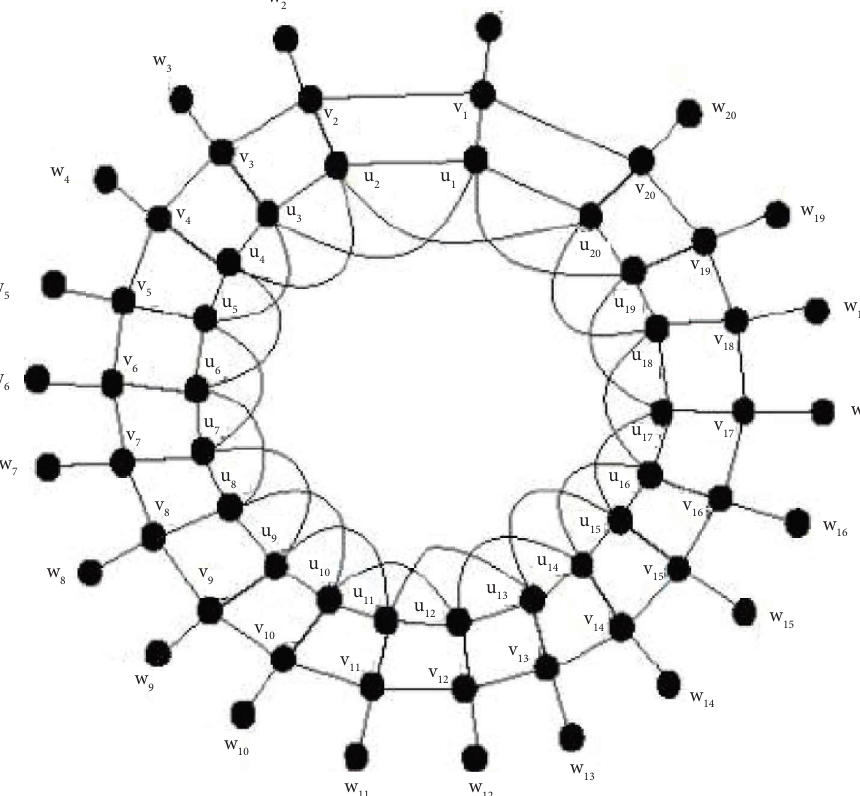
Figure 2: Pendent graph ext ( 1 ) ( G ) for n � 20.